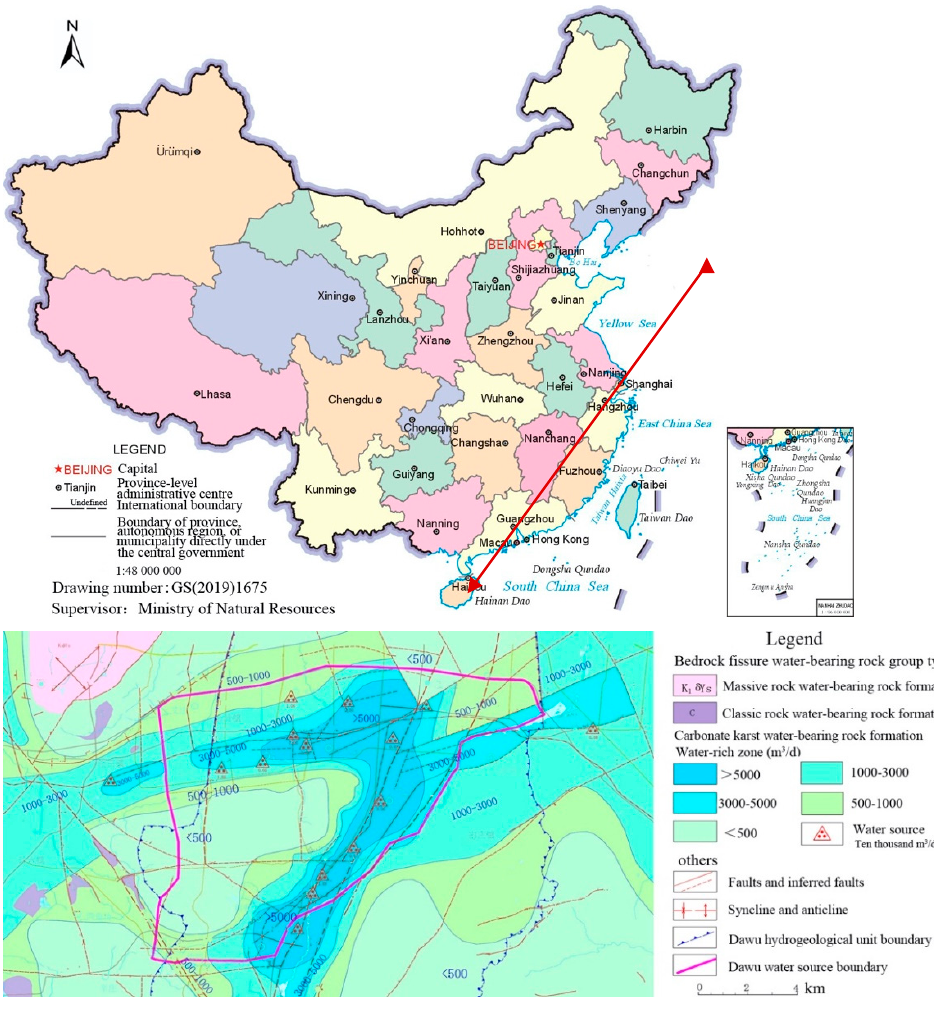
Figure 1. Map of the study area.